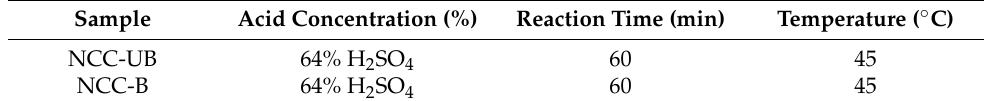
Table 2. Acid hydrolysis conditions employed for the production of nanocrystalline cellulose (NCC) from kenaf core.